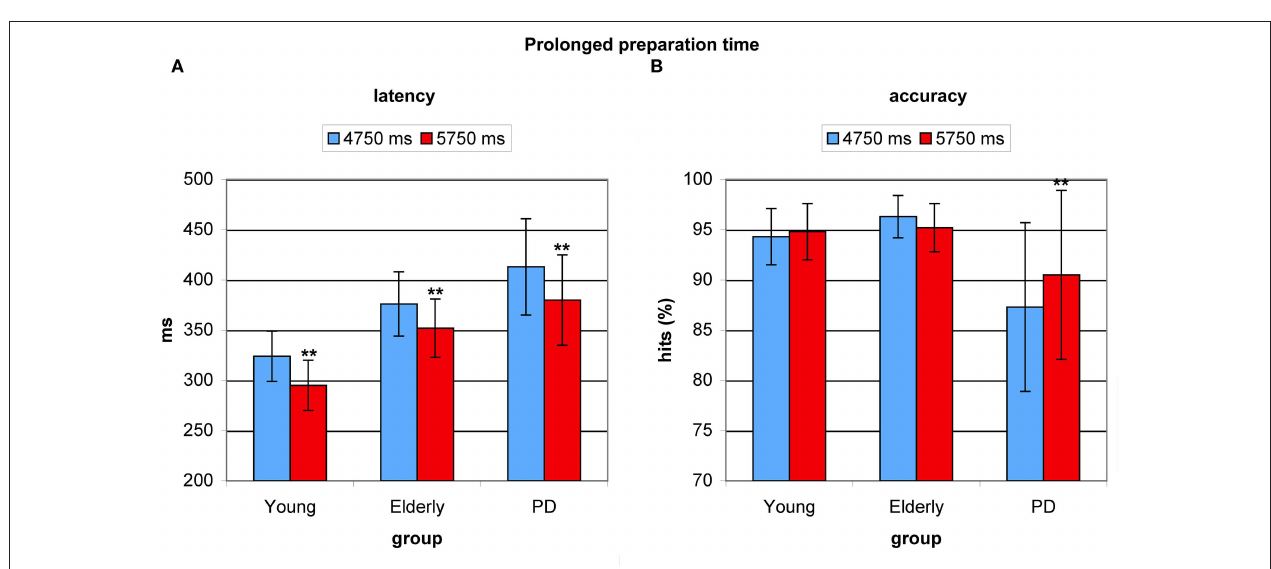
displayed (blue) in all groups. (B) Average antisaccade accuracy was significantly higher on specific preparation trials (red) than on non-specific trials (blue) in the young, and marginally higher in older participants and PD patients. * P < 0.05; ** P < 0.01.